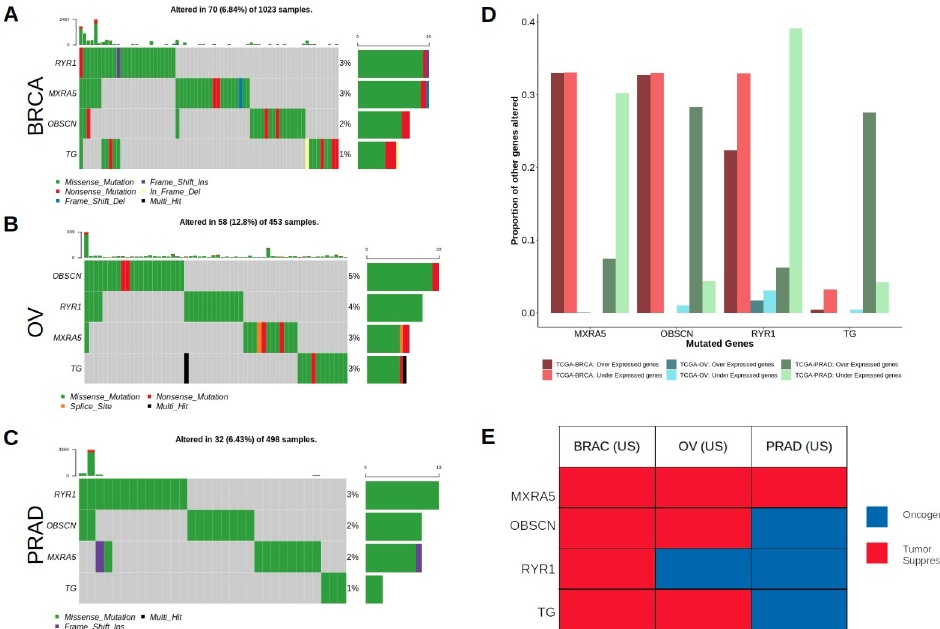
Fig 4. Driver gene discovery in patients with no alterations in COSMIC genes. a-c Oncoplots for 4 significant driver genes discovered in patients with no alterations in COSMIC genes. Oncoplots shown for each gene in our complete datasets (all patients). d) Showing the proportion of genes which experience changes in their expression levels when the four specified genes are mutated in each of the three cancer types–showing both under-expression and over-expression effects. e) Showing the classification as oncogene or tumor suppressor of the four genes in each of our three cancer types.